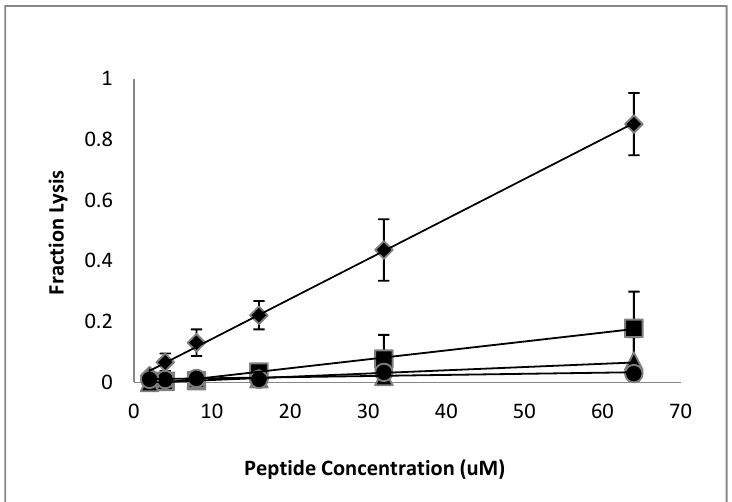
Figure 2. Hemolytic activity of all L-CM15 and CM15 analogs containing D-lysine. Shown is the percent red blood cell hemolysis after 1 h incubation with each respective peptide (mean and standard deviation of at least three independent experiments). Diamonds represent CM15, squares represent D 1,13 , triangles represent D 3,13 , and circles represent D 3,7,13